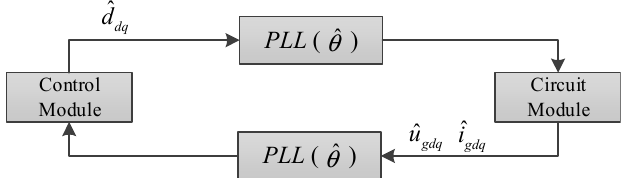
Figure 12. The angular transfer relationship between the circuit module and the control module in GSC.